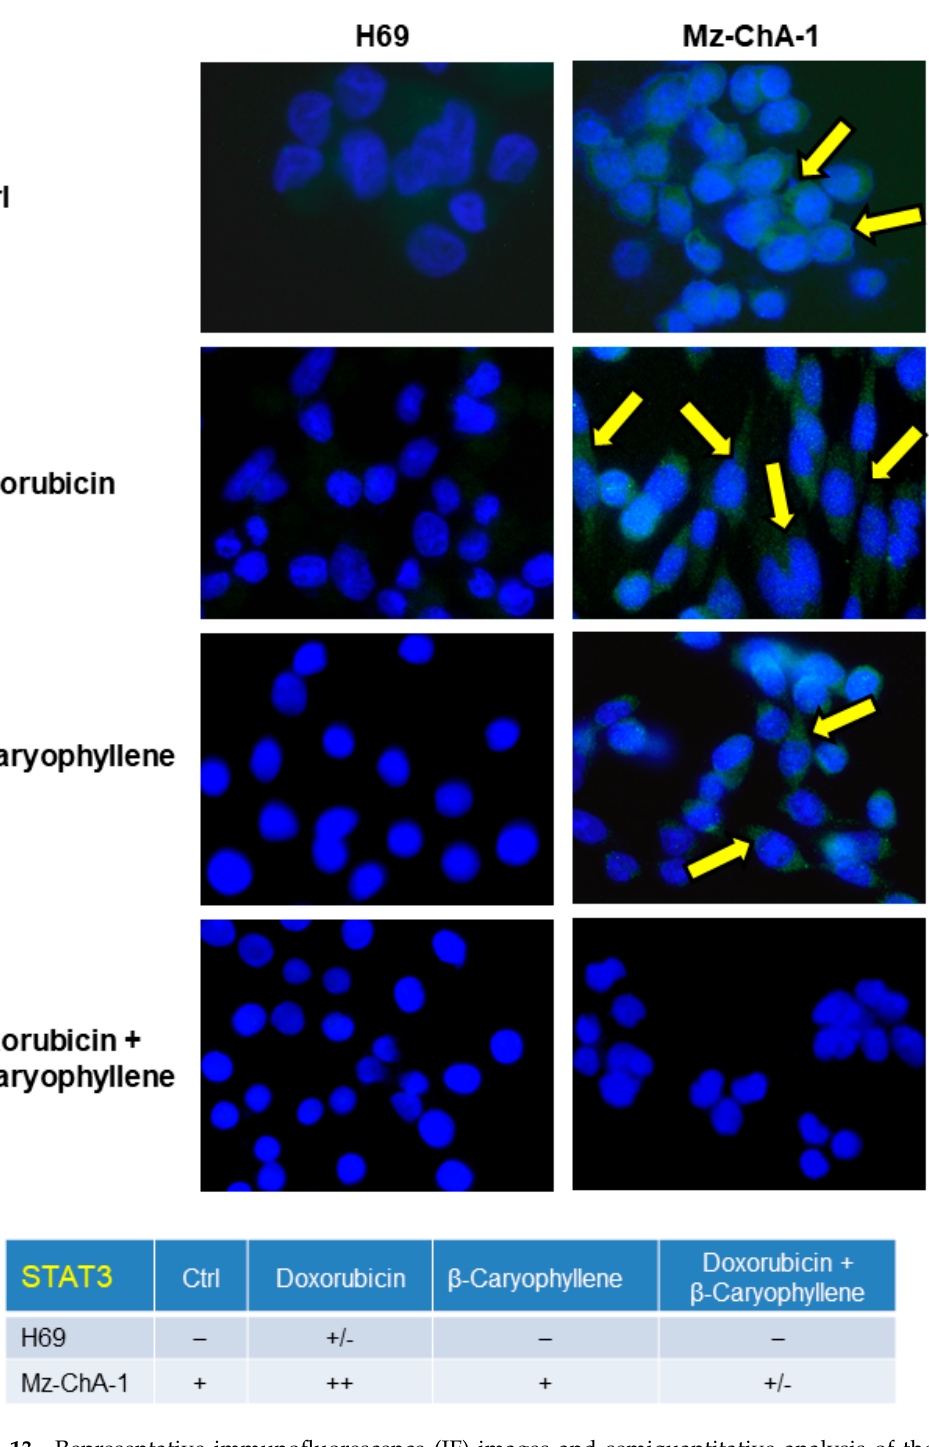
Figure 13. Representative immunofluorescence (IF) images and semiquantitative analysis of the phosphorylatedSTAT3 ontyrosine 705residueinduced bythe naturalsesquiterpene β -caryophyllene(50 µ M),doxorubicin(20 µ M)andtheircombinationcomparedthecontrolinMz-ChA-1cholangiocarcinoma cells and H69 noncancerous cholangiocytes. After treatments of 24 h, the cells were fixed then stained with a specific anti-phospho(Tyr705)-STAT3 primary antibody to assess the protein phosphorylation rate, as shown by the yellow arrows. The semiquantitative analysis has been carried out (four fields for each treatment) applying a previous published grading system [64]: 0%–5% = negative; 6%–10% = +/ − ; 11%–30% = + ; 31%–60% = ++ ; > 61% = +++